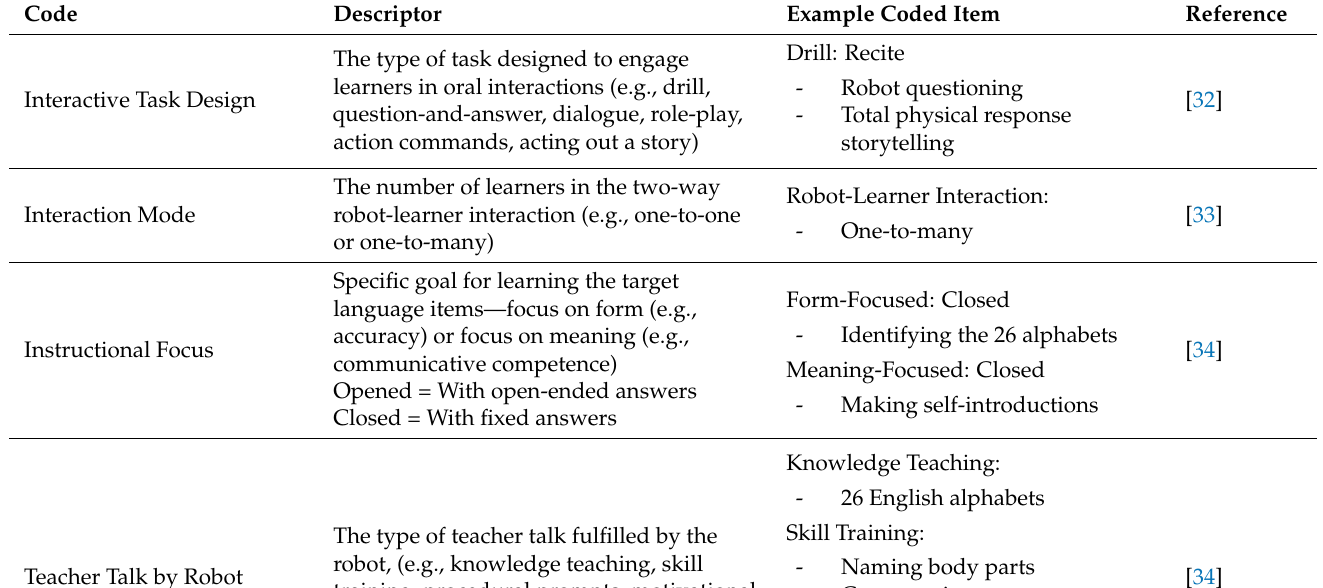
Table 1. Coding Scheme for Task Design for Oral Interactions in